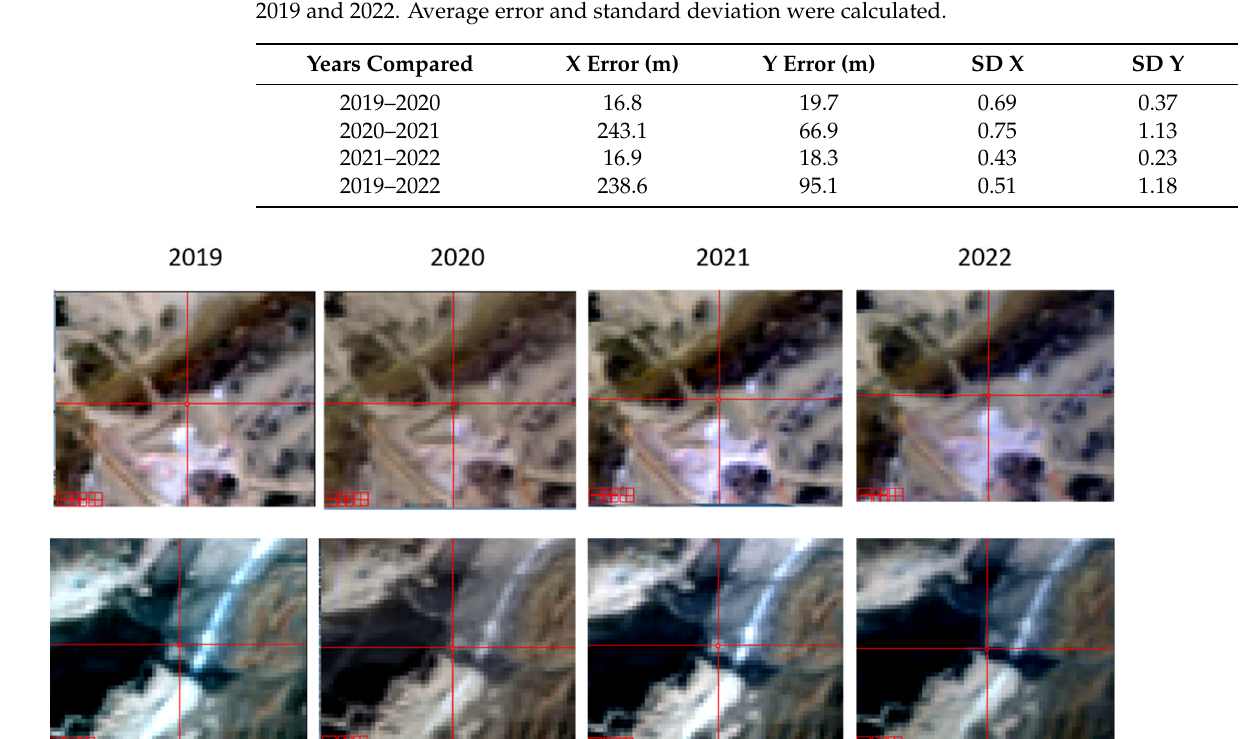
Figure 16. Comparison of the same coordinates (red cross) for the years 2019–2022 at three MR test sites: kaolinite (top panels), gypsum soil fans, and laccolite (bottom panels). There is a slight shift in the locations.